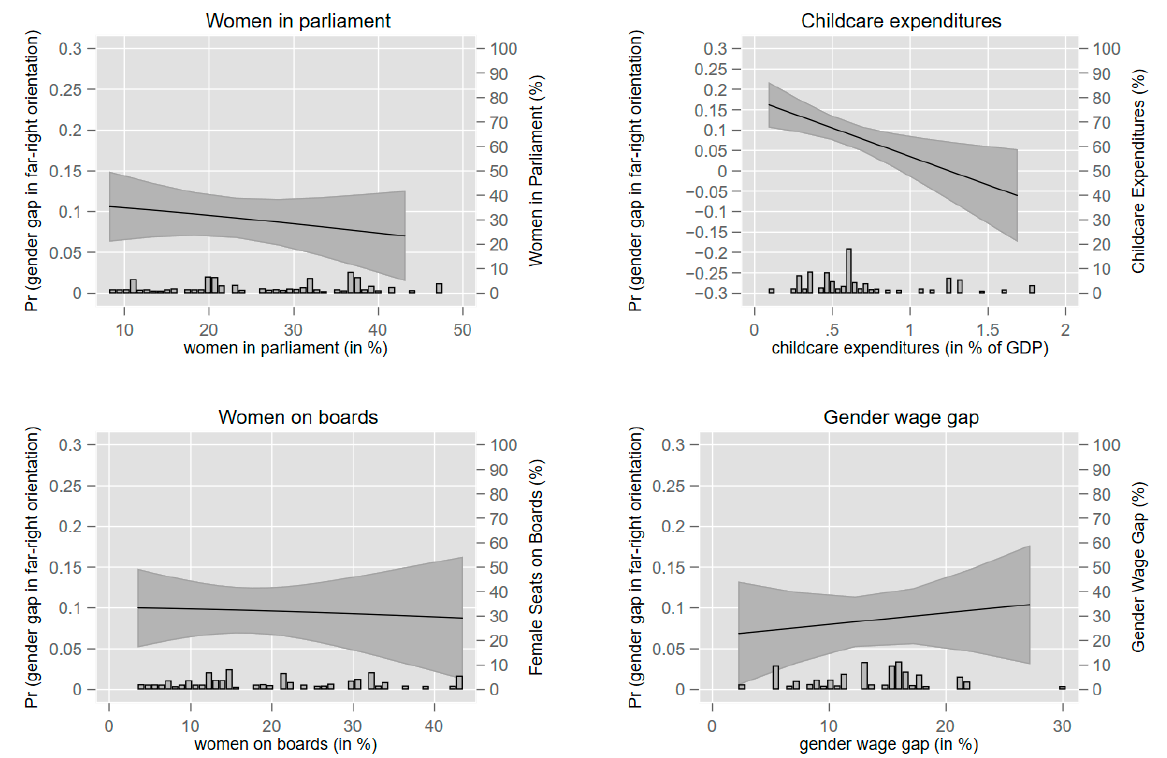
Figure A2. Average marginal-effect plot of men’s preferred job selection on gender gap in far-right orientation.